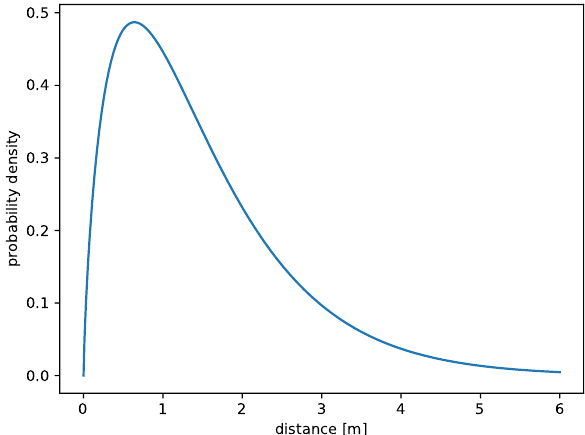
Figure 3. Gamma distribution ( 1.27852,0.74295 ) representing errors of a method based on Wireless LAN.